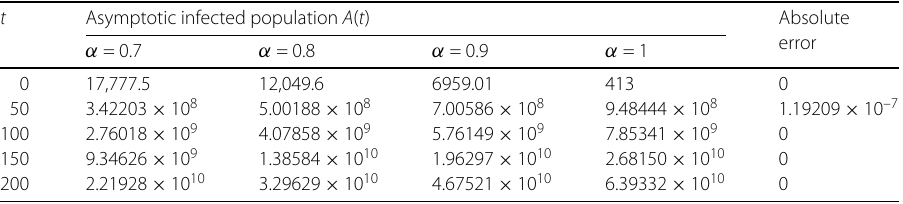
Table 5 Numerical results of asymptomatic infected population A ( t ) for fractional parameter τ = 0.7,0.8,0.9,1 and comparison between classical and approximate solution